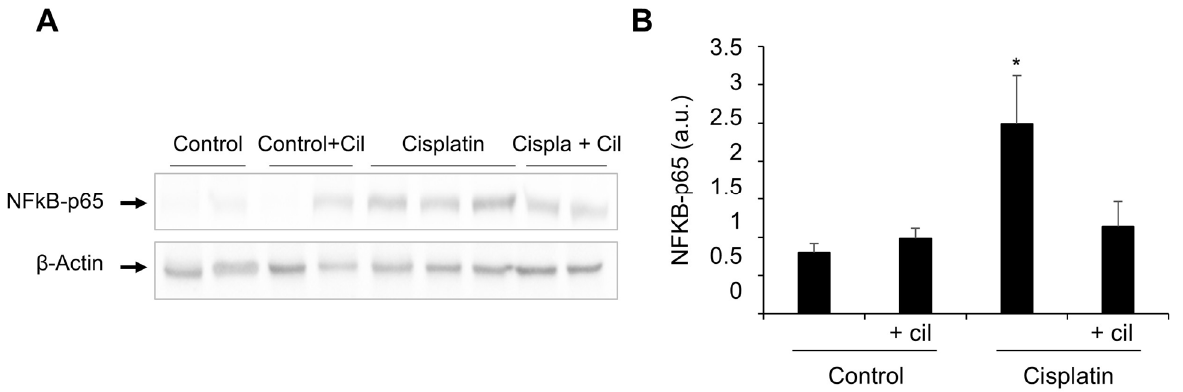
Figure 2. Cilastatin diminishes cisplatin-induced inflammatory NF- κ B upregulation. ( A ) Representative photomicrograph of western blots of the p65 subunit of NF- κ B in renal cortex. ( B ) Densitometric analysis of the p65 subunit on western blots. Cilastatin reduced the NF- κ B values previously increased by cisplatin treatment. Results are expressed as mean ± SEM, * p < 0.03 vs. all other